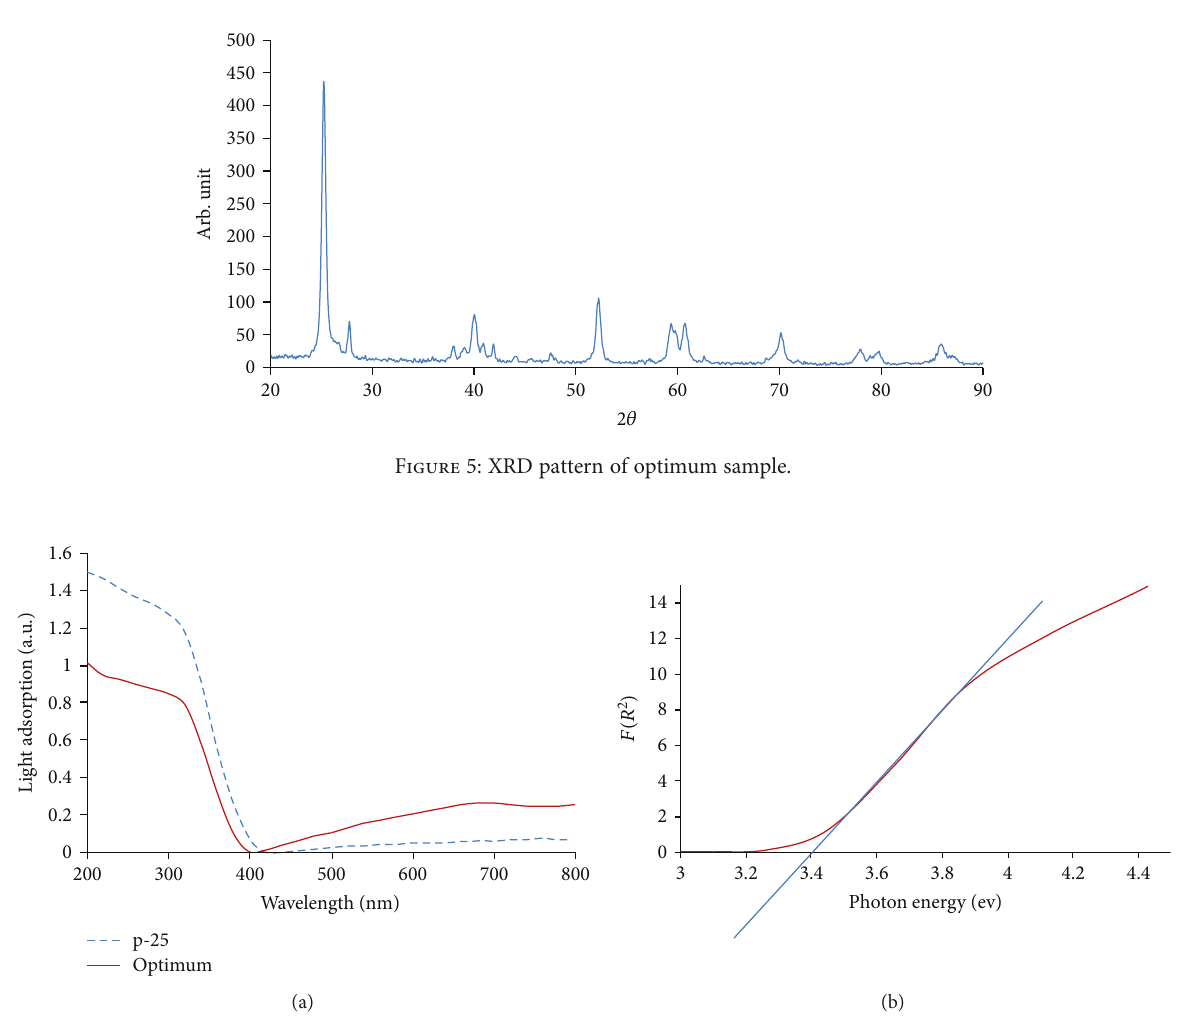
Figure 4: Contour plot for the degradation of DBT indicating the e ff ect of interaction between temperature and p-25